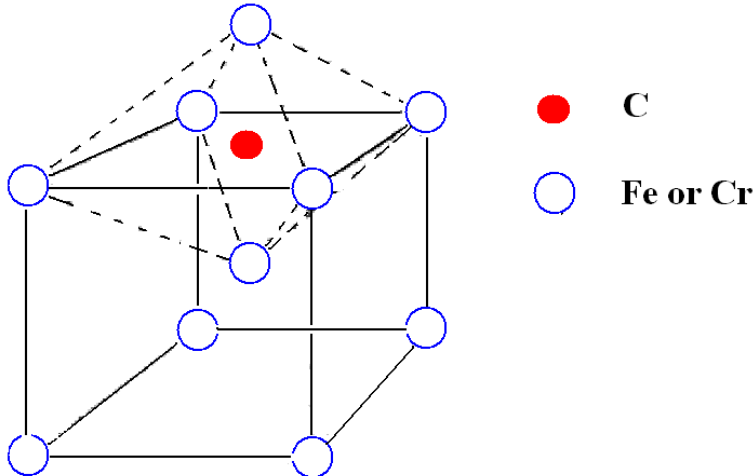
Figure 2. C atoms are allocated in the octahedral interstices of bcc lattice. The corners of the octahedron can be occupied by either Fe or Cr atoms, giving rise to seven possible C–Cr configurations.